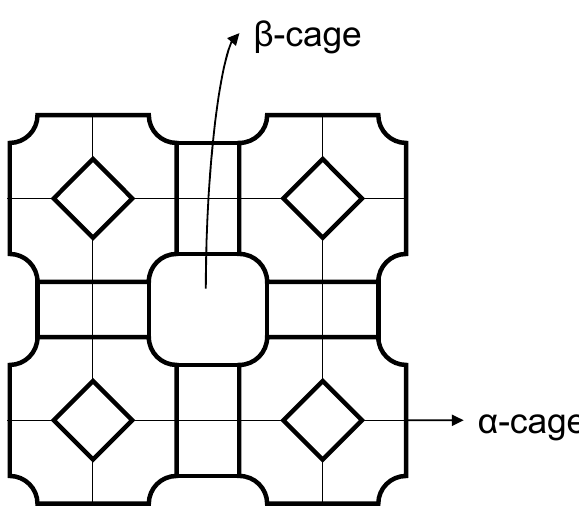
Figure 2. The framework structure of ZK-4 zeolite with α - and β -cage [66].